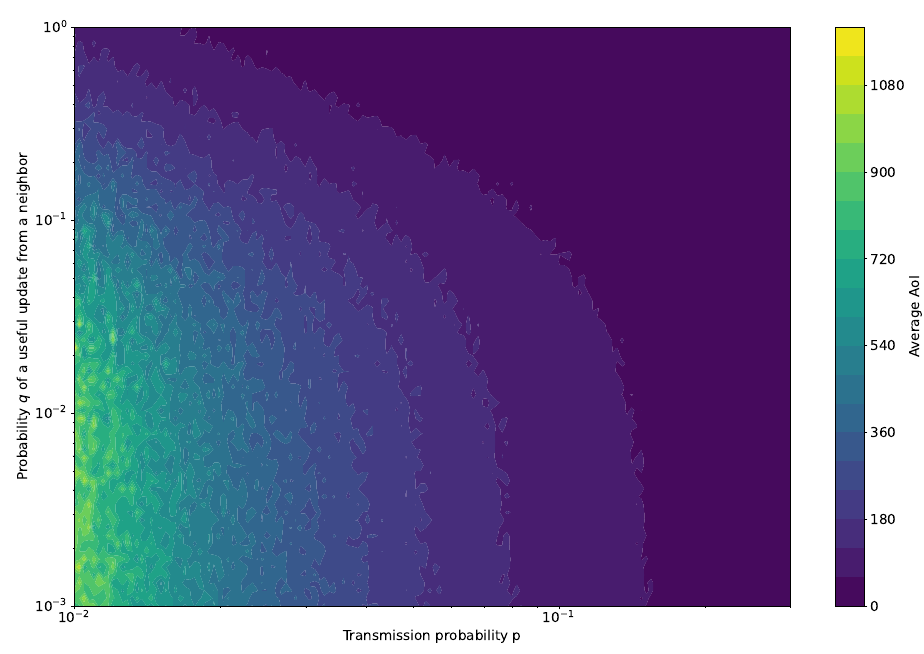
Figure 4. Average AoI obtained from simulations with N = 10.